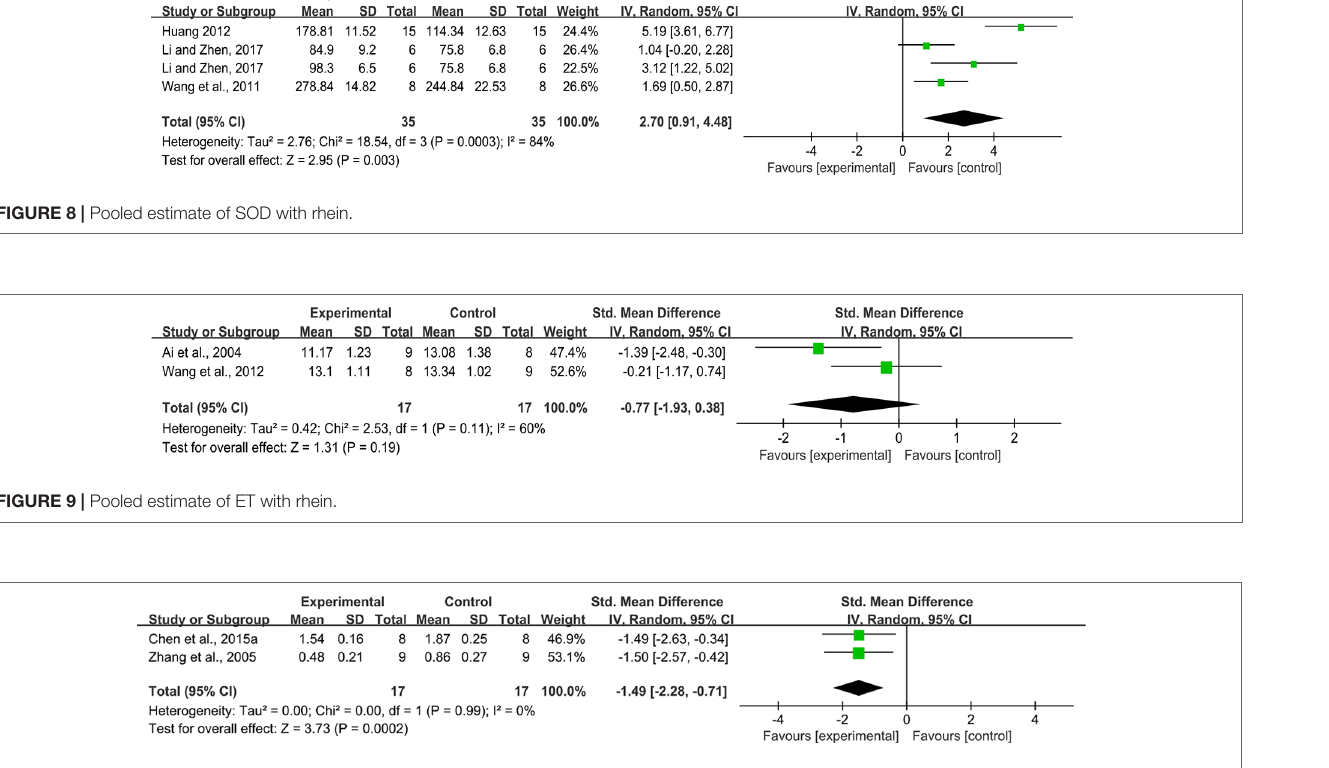
FiGURe 10 | Pooled estimate of TGF-β 1 with rhein.